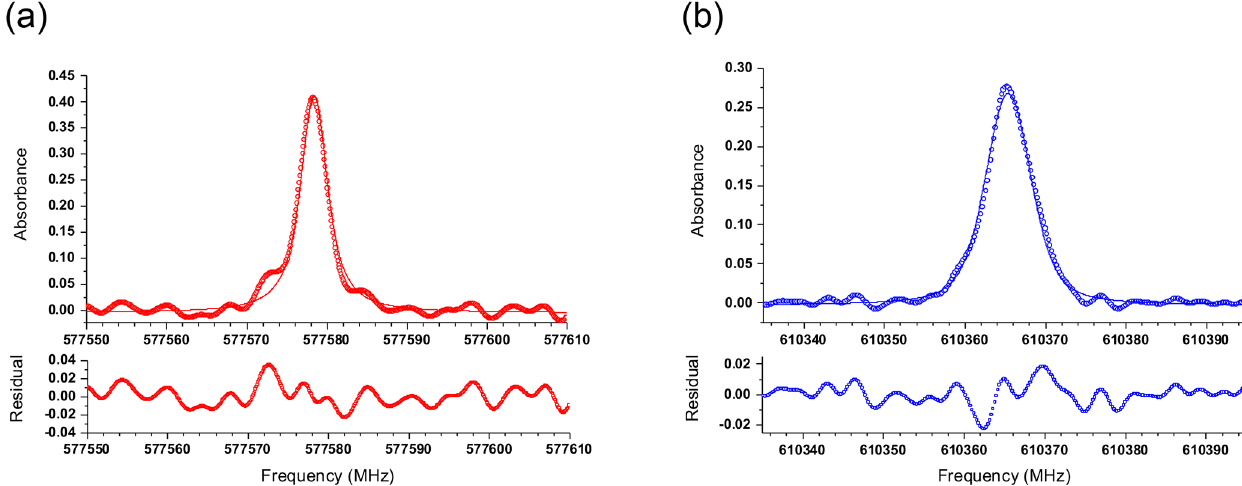
Figure 7. THz trace gas quantification of stable N 2 O and reactive O 3 in MULTICHARME. (a) Red circles: R( 22 ) transition of 1000ppmv N 2 O diluted in N 2 measured at P = 0.5mbar (AM: f mod = 4.5kHz + FM: f mod = 50kHz, ω depth = 1.44MHz); red solid line: fit with a Voigt profile ( (cid:82) A(ν) d ν = 2.4(3)MHz; ν = 577578,36MHz). (b) Blue circles: 25 1 , 25 ← 24 0 , 24 transition of an unknown quantity of O 3 diluted in air produced by an ozone generator measured at P = 1.5mbar (AM: f mod = 4.5kHz + FM: f mod = 50kHz, ω depth = 1.08MHz); blue solid line: fit with a Voigt profile ( (cid:82) A(ν) d ν = 2.3(2)MHz; ν = 610365,35MHz). The residuals between the Voigt fit and the experimental points are given for both lines.